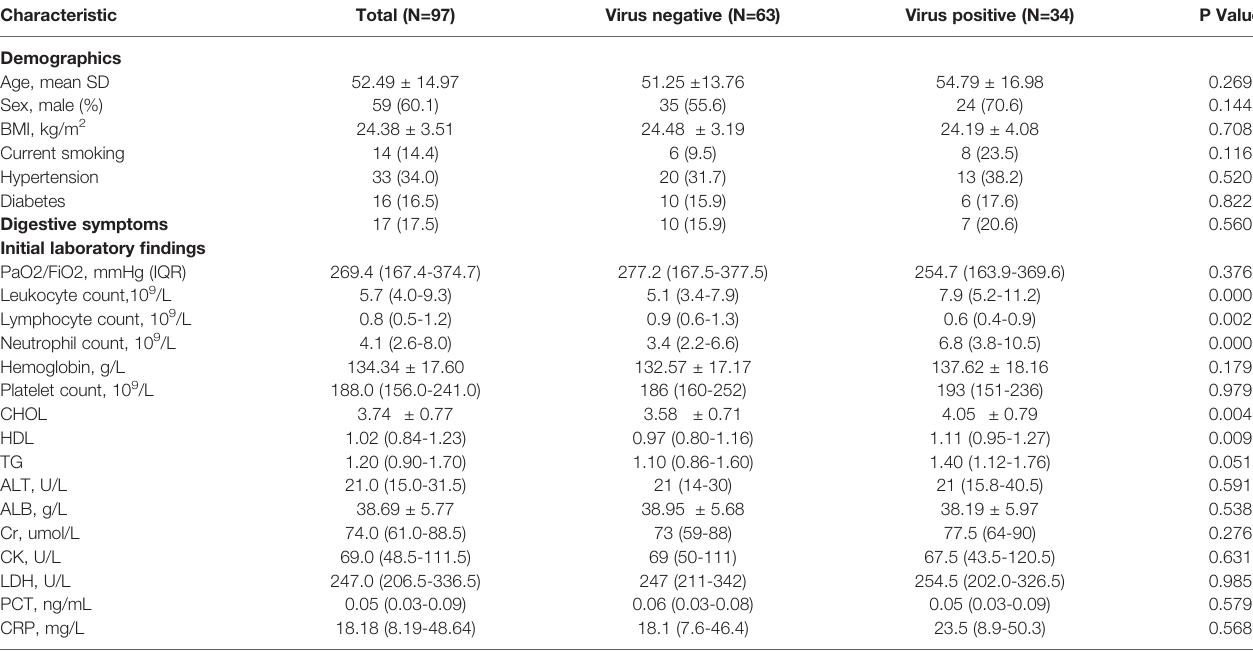
TABLE 1 | Clinical Characteristics of 97 Hospitalized Patients With SARS-CoV-2 Infection. Characteristic Total